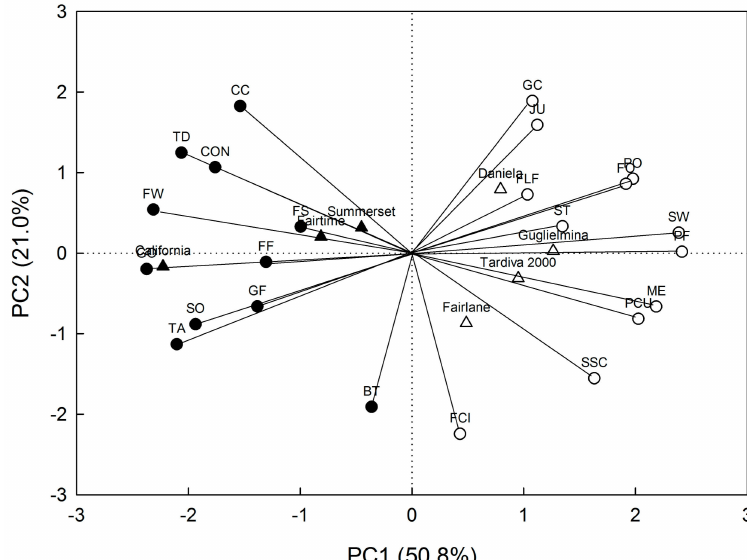
Figure 1. Two-dimensional positioning of cultivars (five peaches and two nectarines) and physical, chemical ( n = 30) and sensory ( n = 20) fruit quality attributes determined by Biplot technique (MDPREF). Trees (500 / ha) were grown near Riesi (37 ◦ 16’ N and 330 m a.s.l.), in central-southern Sicily. Open and closed symbols indicate the two groups obtained by k-means clustering of object and vector coordinates. FW, fresh weight; TD, transversal diameter; FF, flesh firmness; GC, ground color index; CC, percentage of cover color; SSC, soluble solid content; TA titratable acidity; ST, SSC / TA; PCU, peel color uniformity; CON, consistency; ES, easy stone; FCI, flesh color intensity; PO, peach odor; GO, grass odor; FO, flower odor; ME, mealiness; SW, sweetness; BT, bitterness; SO, sourness; JU, juiciness; PF, peach flavor; GF, grass flavor; FLF, flower